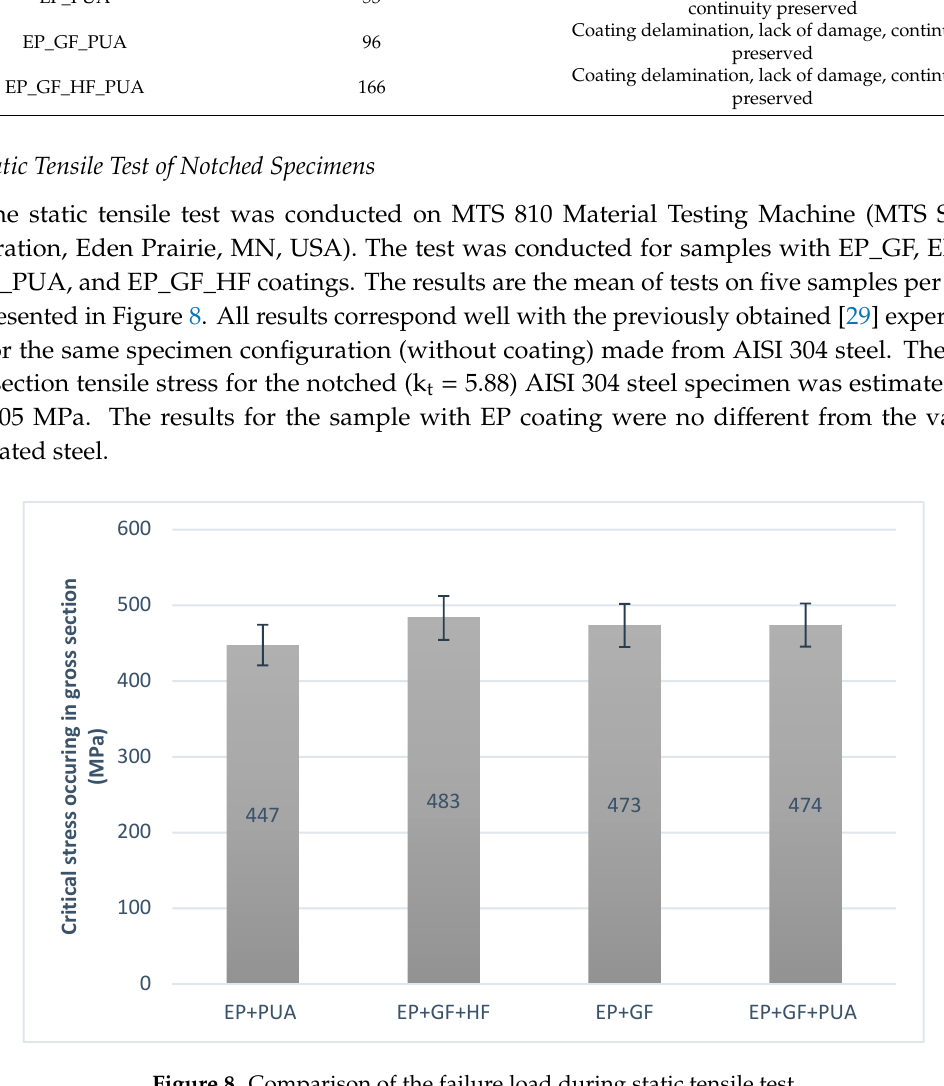
Figure 9. Number of cycles to failure (mean of five) for samples with different coatings. The macroscopic images of broken specimens are presented in Figure 10.